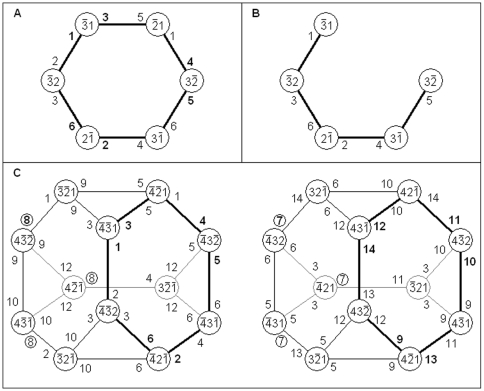
Number of cells required.The directed graphs show that hexagonal columns nearly minimize the number of cells used to construct Complete n-RANCs. Two nodes are linked if they can form a conjunction according to equation 1 or 2 of Table 2. Along each edge, the label representing the response  is shown next to node A, and  is next to B. The edge labels in bold face show the conjunctions as they are implemented in Fig. 1C, D. The graph in A shows all the ways six single 3-RANCs can be formed, and B shows how six single 3-RANCs can be formed with one less cell. The graph in C shows how 4-RANCs can be formed.